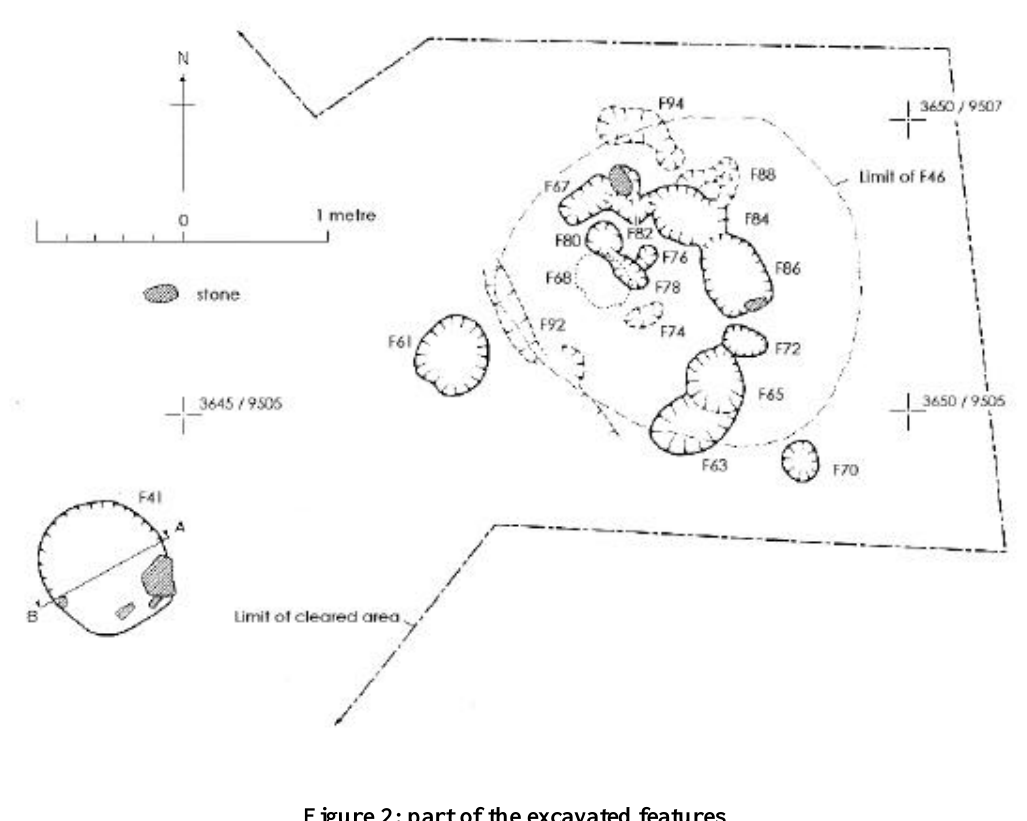
Figure 2: part of the excavated